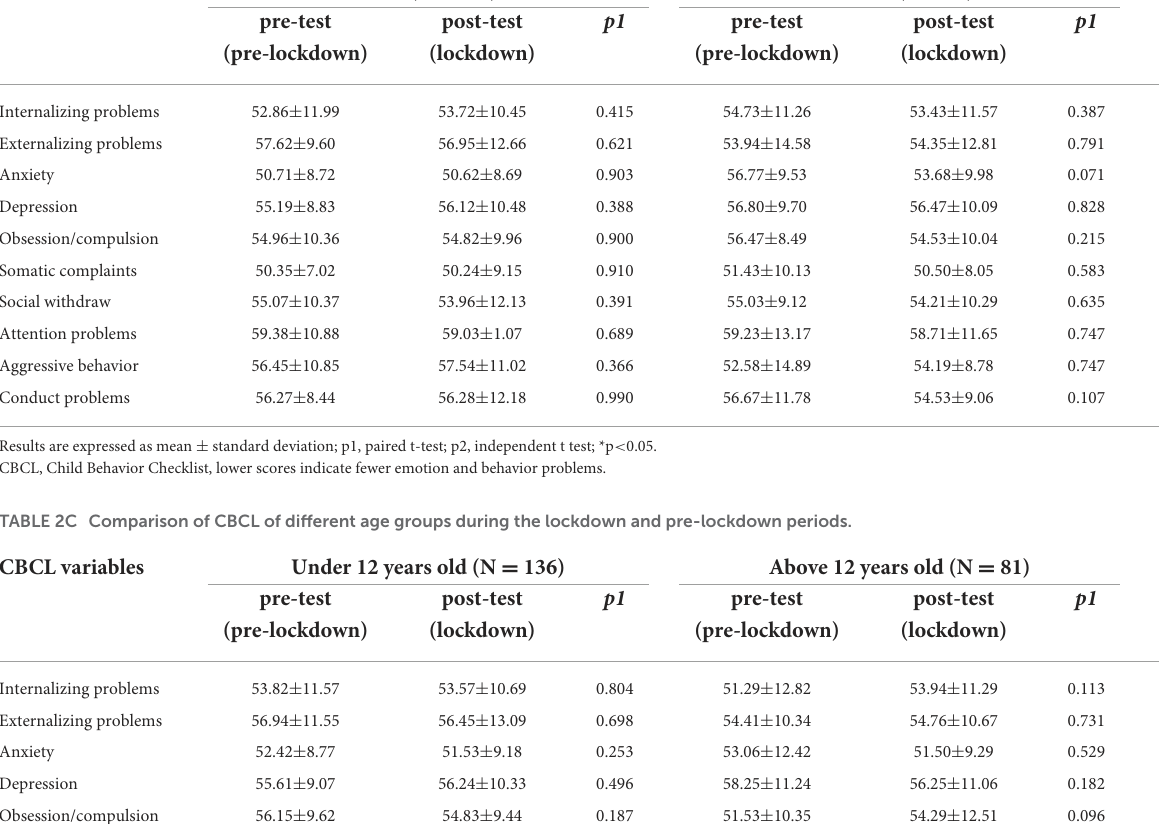
TABLE 2B Comparison of CBCL of different genders during the lockdown and pre-lockdown periods. CBCL variables